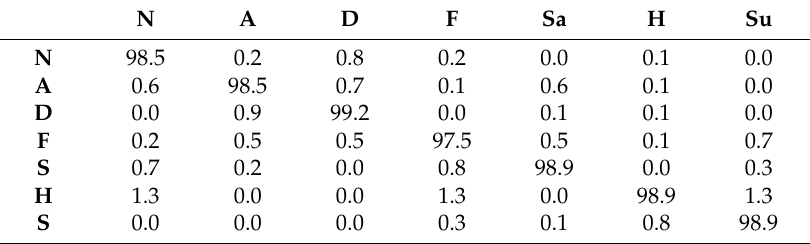
Table 4. The results obtained by the JAFFE database.